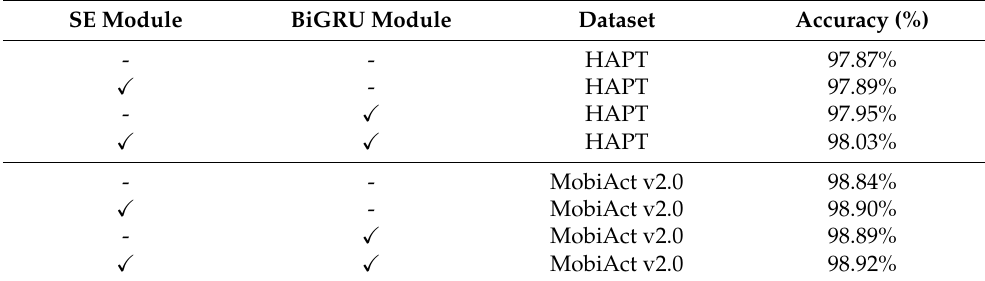
Table 8. Comparison results of ResNet-based models with or without the SE and BiGRU modules. SE Module BiGRU Module Dataset